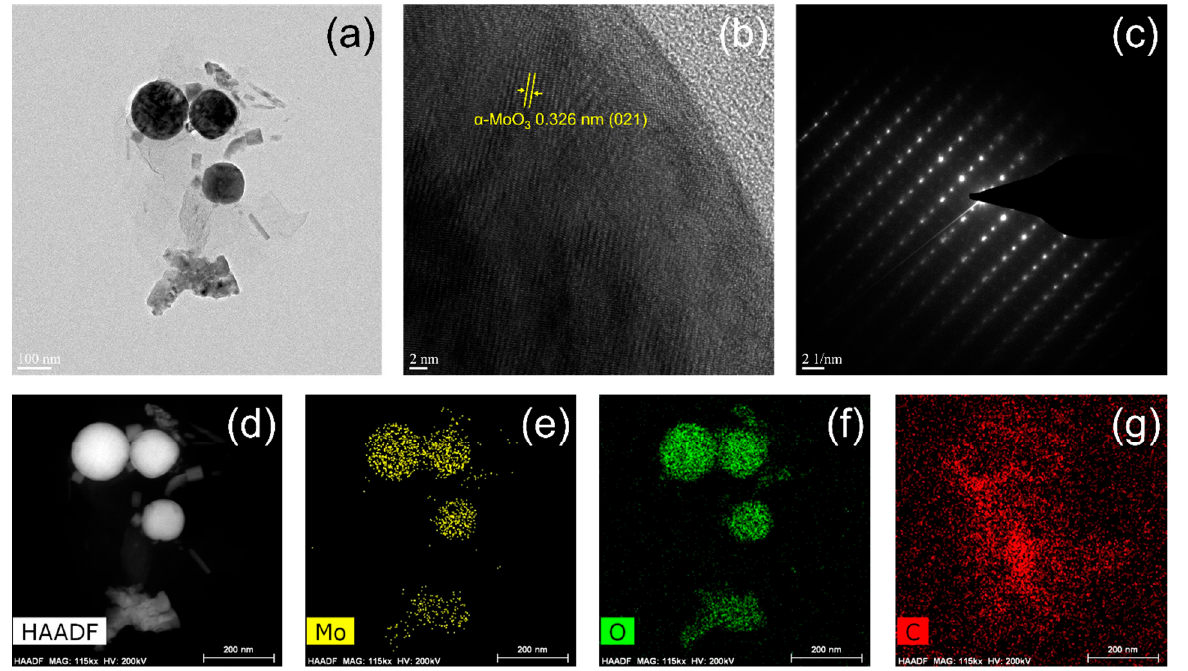
Figure 8. ( a ) Low-magnification and ( b ) high-resolution TEM images, ( c ) SAED pattern, ( d ) HAADF STEM image, and EDS mapping images of ( e ) Mo, ( f ) O, and ( g ) C, acquired for the molybdenum oxide nanoparticles (NPs) prepared by the CVT method using MoO 3 precursor. The NPs were harvested from the CFP substrates for the characterization.